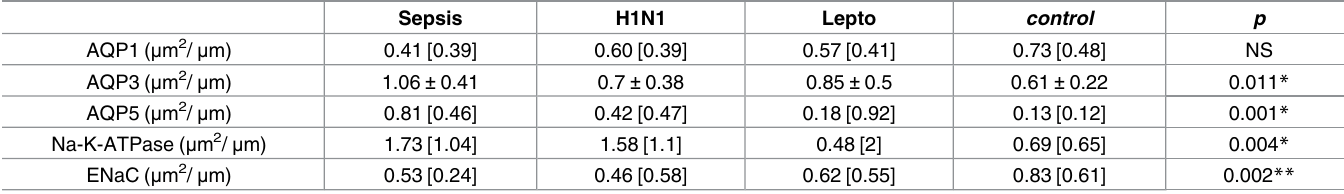
Table 3. Protein expression in DAD subgroups and control